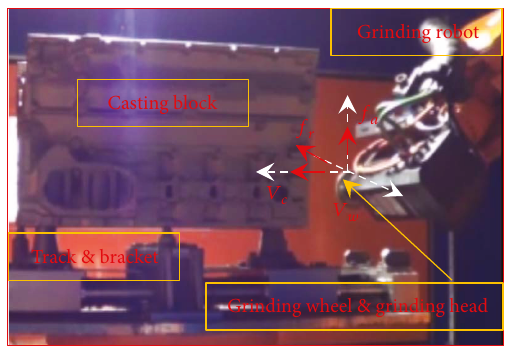
Figure 8: Parameters of grinding